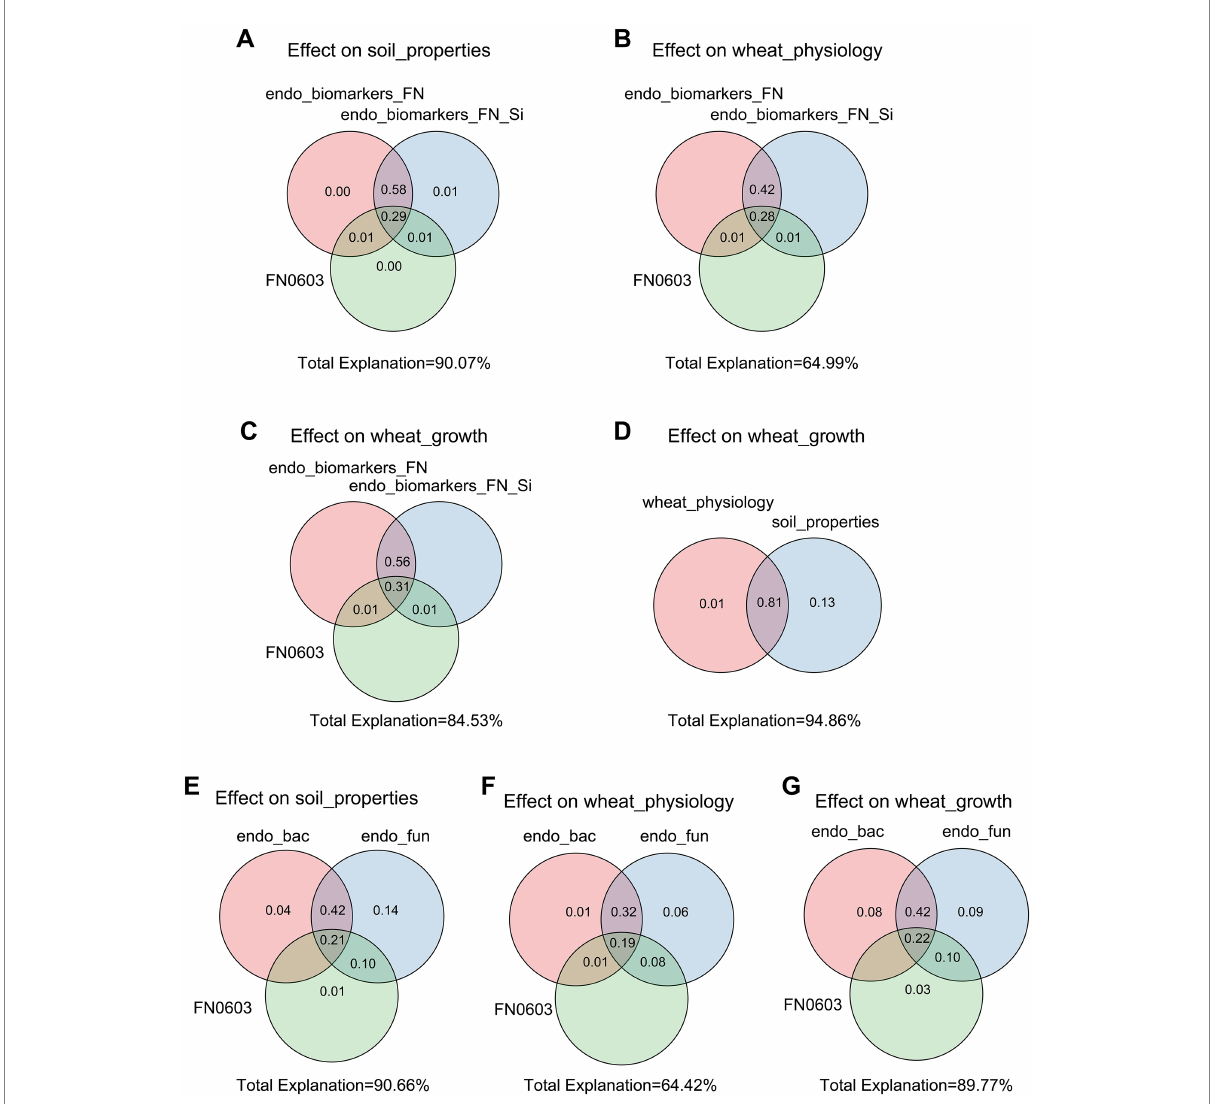
FIGURE 6 Variation partitioning analysis (VPA) evaluated the explanatory degree of FN0603, endo_biomarkers_FN and endo_biomarkers_FN_Si to the variation of (A) soil properties, (B) wheat physiology and (C) wheat growth. The explanatory degree of soil properties and wheat physiology to the variation of (D) wheat growth. The explanatory degree of FN0603, root endophytic bacterial communities and root endophytic fungal communities to the variation of (E) soil properties, (F) wheat physiology, and (G) wheat growth. All the specific biomarkers were FN0603-specific